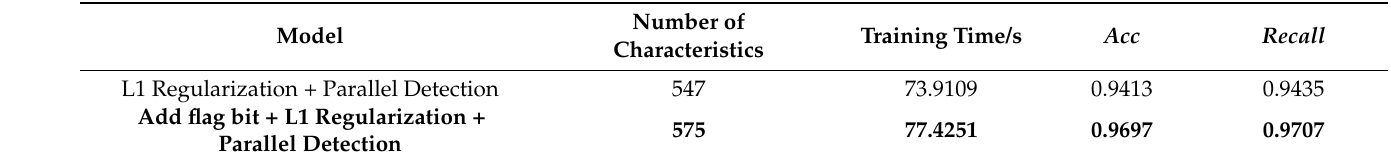
Table 7. Experimental analysis of parallel detection